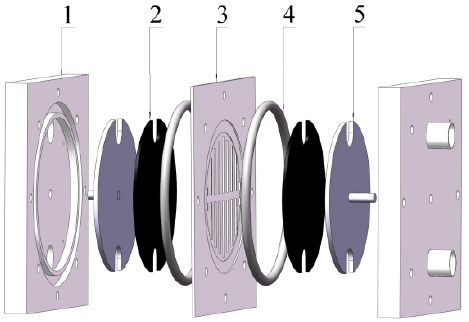
Figure 2. Schematic view of modular ZnBr 2 single cell structure. 1. Shell frame, 2. Carbon felt, 3. Membrane frame, 4. O-ring, 5. Titanium foam.